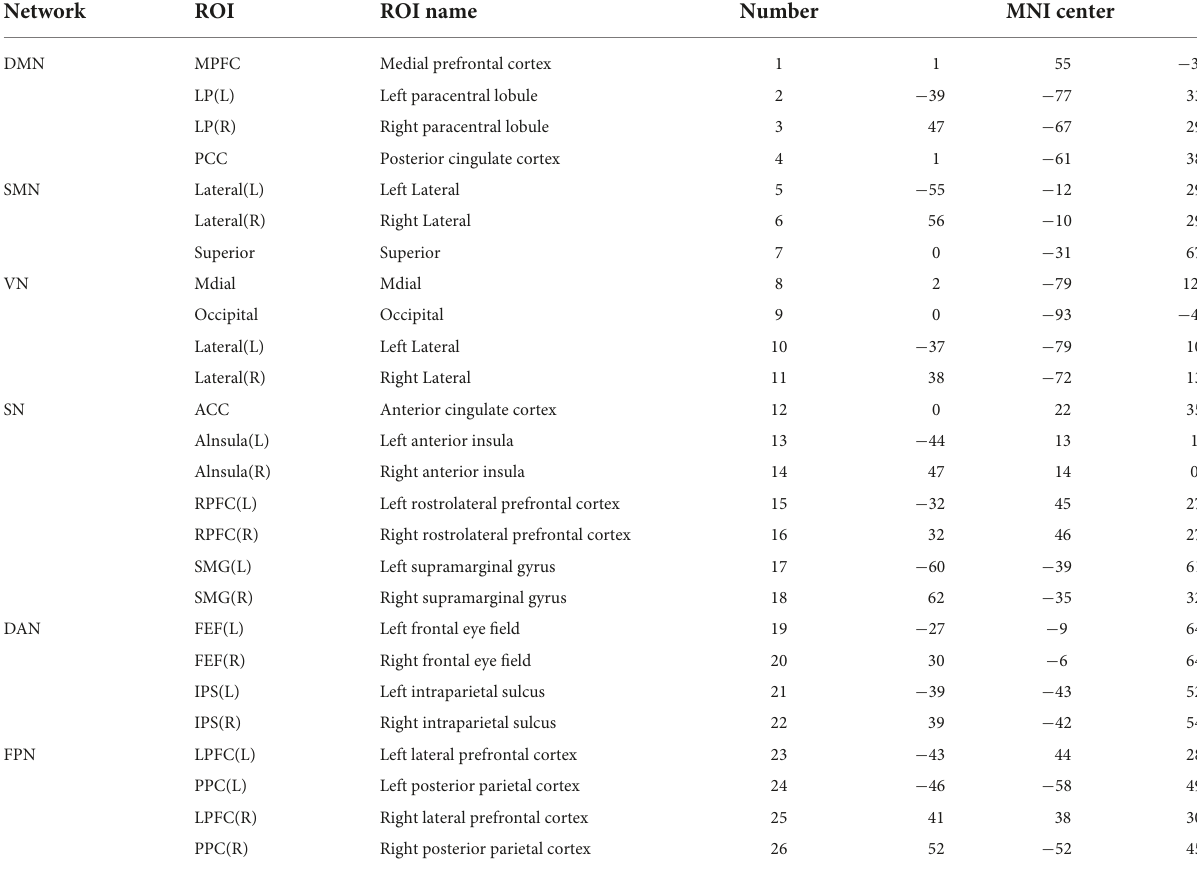
TABLE 1 Abbreviated names and coordinates of 26 regions of interests (ROIs) in the resting-state network. Network ROI ROI